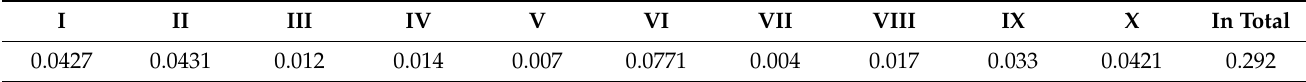
Table A6. Results by items (HR